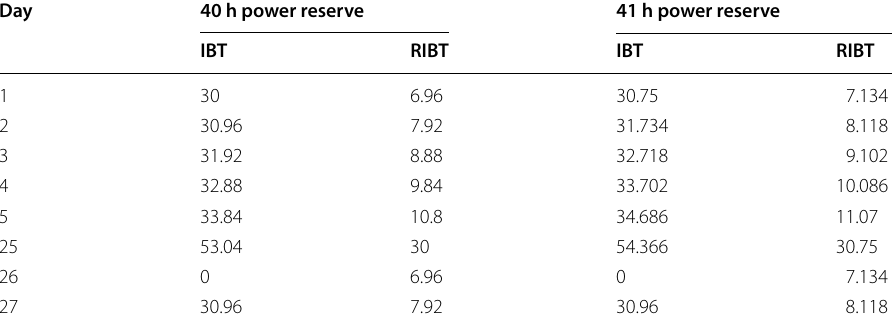
Table 3 In beat time and remaining in beat time for power reserves 40 and 41 Day 40 h power reserve